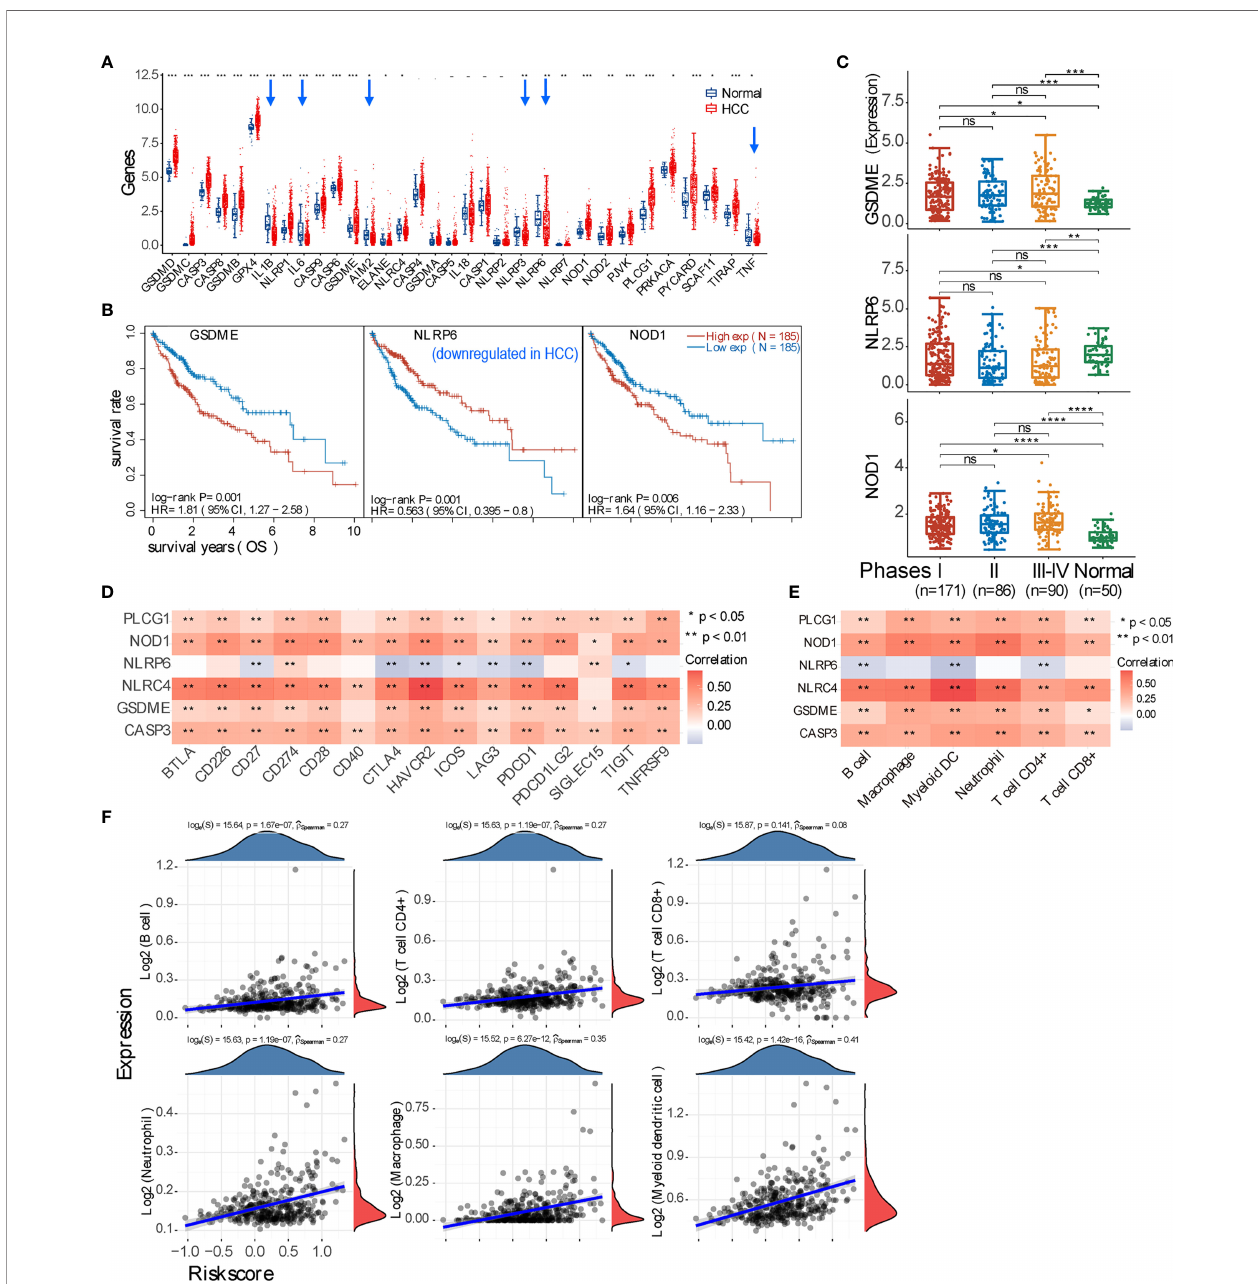
FIGURE 4 | Expression of pyroptosis marker genes and their immune correlation in the context of hepatocellular carcinoma (HCC). (A) Expression pro fi le of pyroptosis marker gene in HCC and normal tissue. The downregulated genes in HCC are pointed by blue arrows. (B) Three marker genes are signi fi cantly correlated with prognosis (p < 0.01); speci fi cally, NLRP6 positively correlates with the overall survival of HCC patients. (C) Expression comparison of these 3 genes (GSDME, NLRP6, and NOD1) in HCC patients with pTNM stage I, II, or III – IV. (D, E) Correlation analysis between all genes that have p < 0.05 correlation with prognosis and checkpoint molecules, or immune cell in fi ltration. (F) Spearman ’ s correlation analysis between the risk score of the prognostic model (calculated from the 3 marker genes) and immune score. *p < 0.05; **p < 0.01; ***p < 0.001; ****p < 0.0001; ‘ - ’ , ns, no statistical signi fi